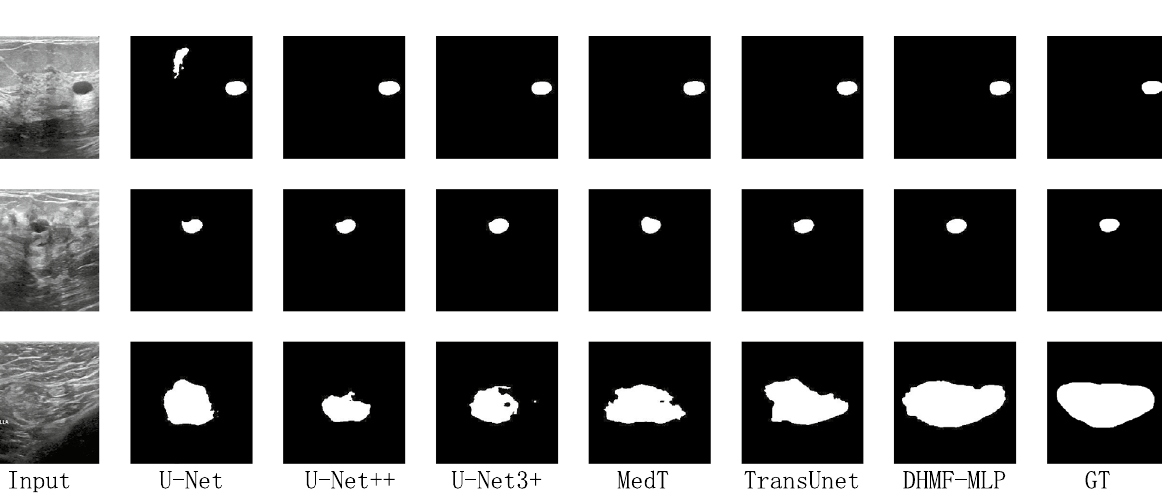
Figure 5. Qualitative comparison results for the BUSI dataset. From left to right: Input, U-Net 14 , U-Net++ 16 , U-Net3+ 28 , MedT 50 , TransUnet 42 , DHMF-MLP and GT. (created by ‘Microsoft Office Visio 2013’ URL: https:// www. micro soft. com/ zh- cn/ micro soft- 365/ previ ous- versi ons/ micro soft- vision-